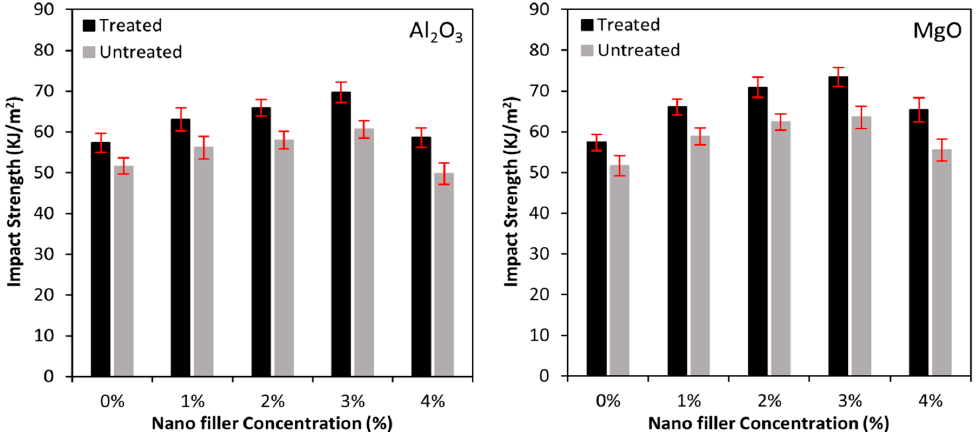
Figure 5. Impact strength of nano Al 2 O 3 and MgO incorporated biotex flax/PLA epoxy hybrid composites.